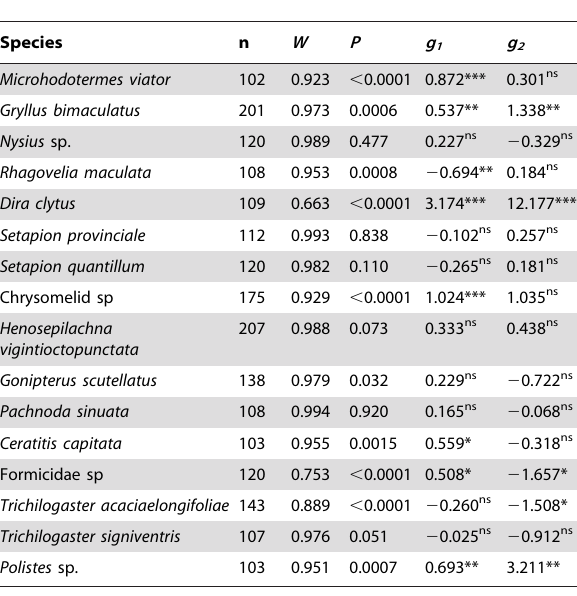
Table 2. Outcome of the assessment of deviation from normality (Shapiro-Wilks W statistic) and the degree of skewness ( g 1 ) and kurtosis ( g 2 ) for the untransformed body mass frequency distributions of all 16 insect species